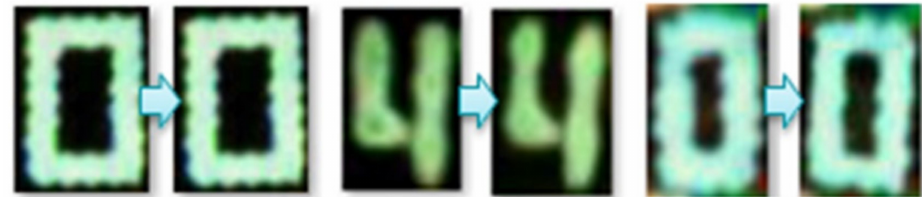
Figure 8. Random rotation of data at an angle within ± 5 degrees.